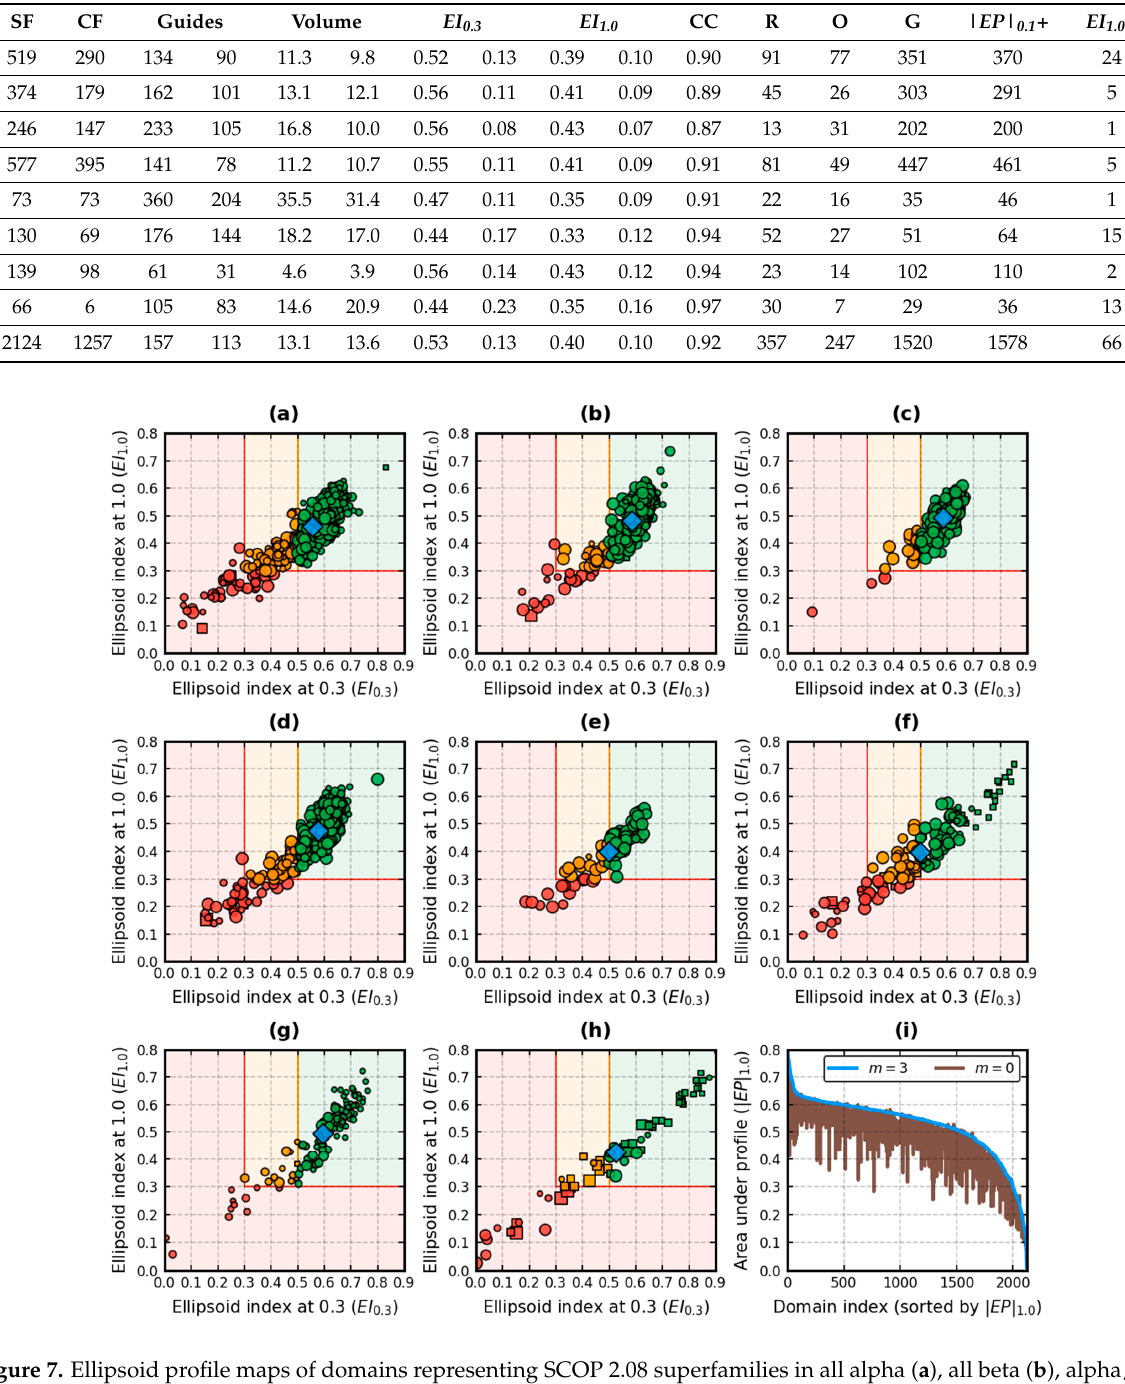
Figure 7. Ellipsoid profile maps of domains representing SCOP 2.08 superfamilies in all alpha ( a ), all beta ( b ), alpha/beta ( c ), alpha+beta ( d ), multi-domain ( e ), membrane and cell surface ( f ), small ( g ) and coiled coil ( h ) classes. Color of the markers matches color of the zone they are occupying (red, orange, green). Size of the markers denotes total number of residues, clipped to 50–200 range. Shape of the markers signals value of T coefficient: circle—less than 2 (ellipsoidal shape), square—2 or more (elongated shape). Blue diamonds mark position of average values of EI 0.3 and EI 1.0 . Data ranges of axes on ( a – h ) are limited to 0.9 and 0.8 respectively for visibility. There are only two domains which lie outside them: d5nw3a_ (0.91 × 0.82, class g ) and d1ca4a2 (0.91 × 0.80, class h ). Chart on ( i ) compares |EP| 1.0 values between m = 3 and m = 0.